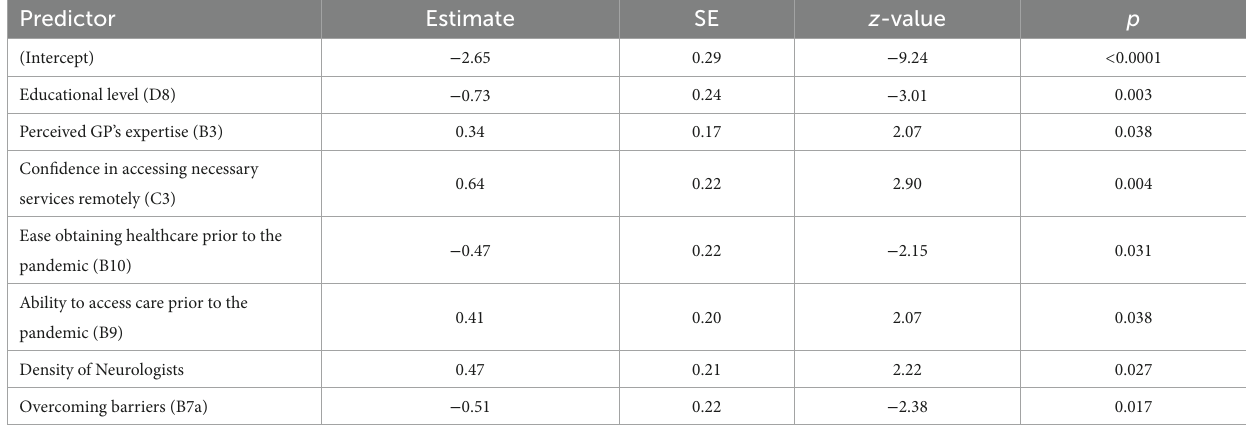
TABLE 2 Significant factors contributing to unmet care needs during the COVID-19 pandemic according to the reduced GLM.